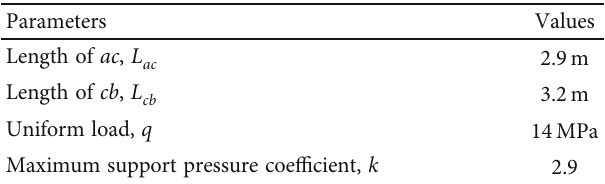
Figure 5: Numerical calculation model. Table 2: Basic parameters of the numerical